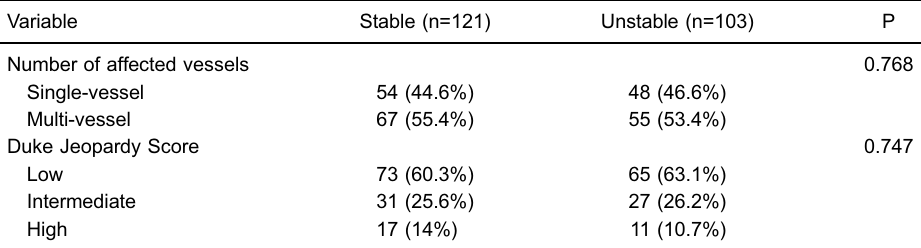
Table 2. Angiographic fi ndings and Duke Jeopardy Score of patients undergoing elective coronary angiogram according to clinical presentation of obstructive coronary artery disease. Variable